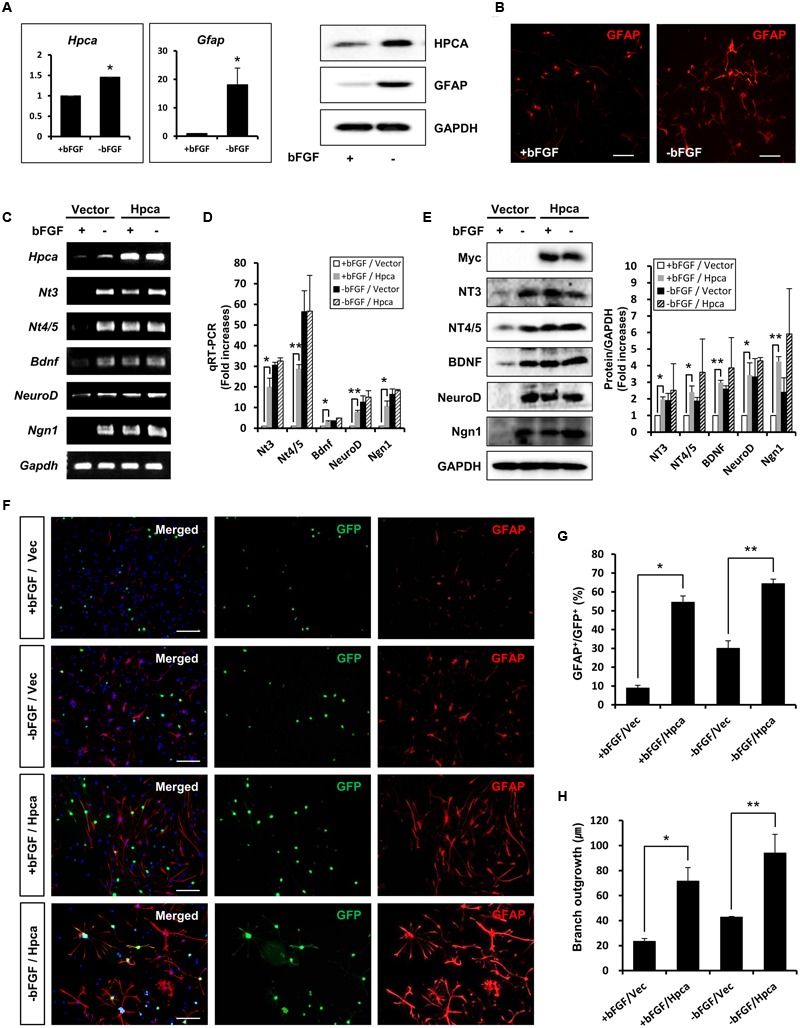
Effect of Hippocalcin (Hpca) on GFAP expression during differentiation of HNPCs. (A,B) HNPCs were induced to differentiate by withdrawal of bFGF. (A) After 48 h, mRNA levels of Hpca and Gfap were determined by real-time PCR. ∗p < 0.001 compared with the +bFGF control. 20 μg aliquots of protein were analyzed by western blotting with anti-hippocalcin, anti-GFAP, and anti-GAPDH. (B) The cells were stained with anti-GFAP (red). Bar, 100 μm. (C–E) Cells were transfected with pMSCV-IRES-EGFP or pMSCV-Hpca-myc-IRES-EGFP for 48 h and then incubated for 24 h after removal of bFGF. The mRNA levels of neurotrophins and proneural bHLH transcription factors were analyzed by RT-PCR (C) and real-time PCR (D). Data are means ± SD of three independent experiments. ∗p < 0.05; ∗∗p < 0.01 compared with the +bFGF/vector control. (E) Proteins were analyzed by western blotting with anti-Myc, anti-NT-3, anti-NT-4/5, anti-BDNF, anti-NeuroD, anti-Neurogenin 1, and anti-GAPDH. Graph shows mean densities as fold increases in three independent experiments (mean ± SD). Band intensities were quantified with Quantity Ones software. ∗p < 0.05; ∗∗p < 0.01 compared with the +bFGF/vector control. (F) HNPCs were transduced with EGFP vector or Hpca-myc-EGFP for 48 h and induced to differentiate by withdrawal of bFGF. After differentiation for 72 h, fixed cells were immunostained with anti-GFP (green) and anti-GFAP (red). GFP-stained cells fluoresce green, and GFAP-stained cells fluoresce red, while cells stained with both GFP and GFAP fluoresce yellow. Bar, 100 μm. (G) Graph shows the percentages of GFAP-positive cells. GFAP-positive cells among GFP-positive cells were counted under a fluorescence microscopy. The proportions of GFAP-positive cells were determined in randomly selected areas from five cultures (means ± SD). ∗p < 0.001 compared with the +bFGF/vector control. ∗∗p < 0.001 compared with the –bFGF/vector control. (H) Branch lengths were measured in random areas from five cultures (means ± SD). ∗p < 0.01 compared with the +bFGF/vector control. ∗∗p < 0.01 compared with the –bFGF/vector control.